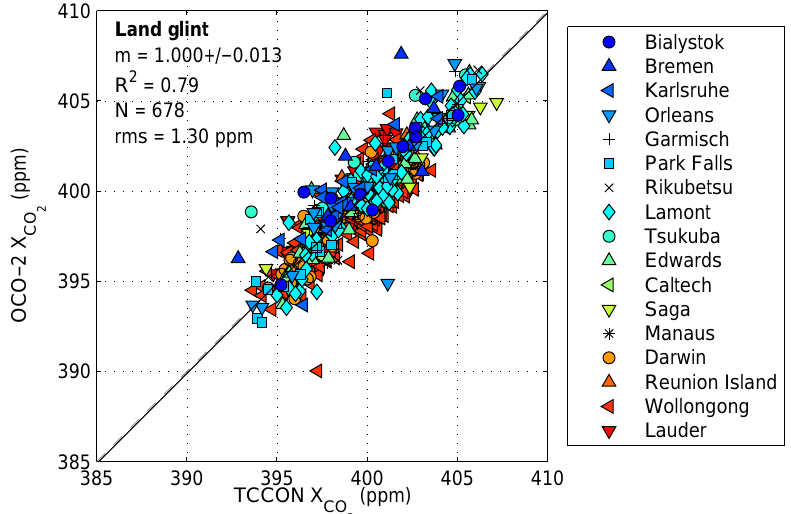
Figure 12. Land glint OCO-2 one-to-one plot against TCCON. The slope of the relationship is represented by “ m ” in the figure, and the coefficient of determination is represented by “ R 2 ”. The number of points on the graph is indicated by “ N ” and the root-mean-square value (RMS) of the differences between OCO-2 and TCCON X CO is also shown. Each point represents a daily median of coincident OCO-2 and 2 TCCON measurements. Many points are overlaid in this graph, obscuring the density of points along the best fit line.